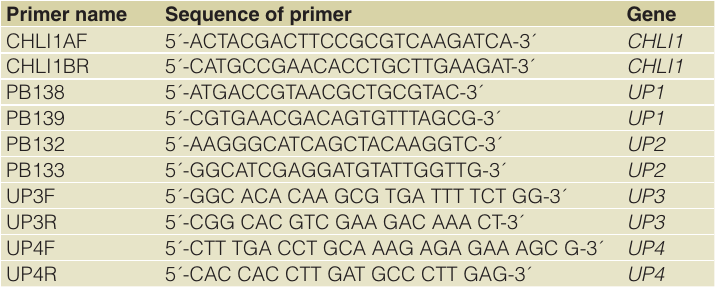
Table 3. List of primers used for amplifying CHLI1 , four neighboring genes upstream of CHLI1 and the actin gene and transcript. These primers were used to generate the data in Figure 6B and 6C. The gene loci in Phytozome (http://www.phytozome.net/) are: CHLI1 (Cre06.g306300), FDX3 (Cre06.